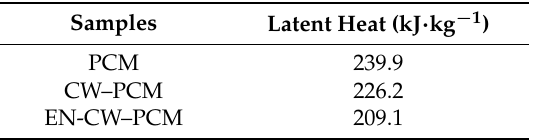
Table 1. The calculated latent heat of each